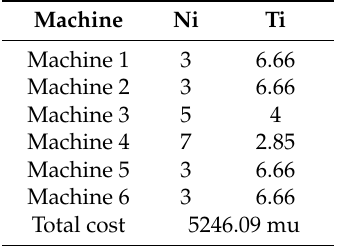
Table 6. Case 2: Maintenance plan for individual maintenance